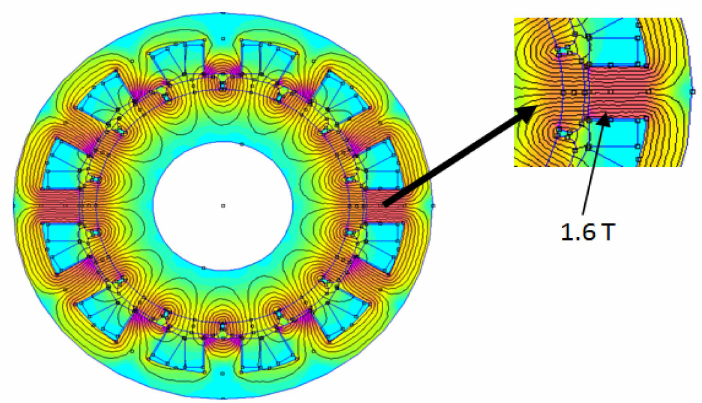
Figure 2. The magnetic flux distribution in a concentrated winding structure with 14 poles and 12 slots. At no-load case, the highest level of magnetic induction is in the